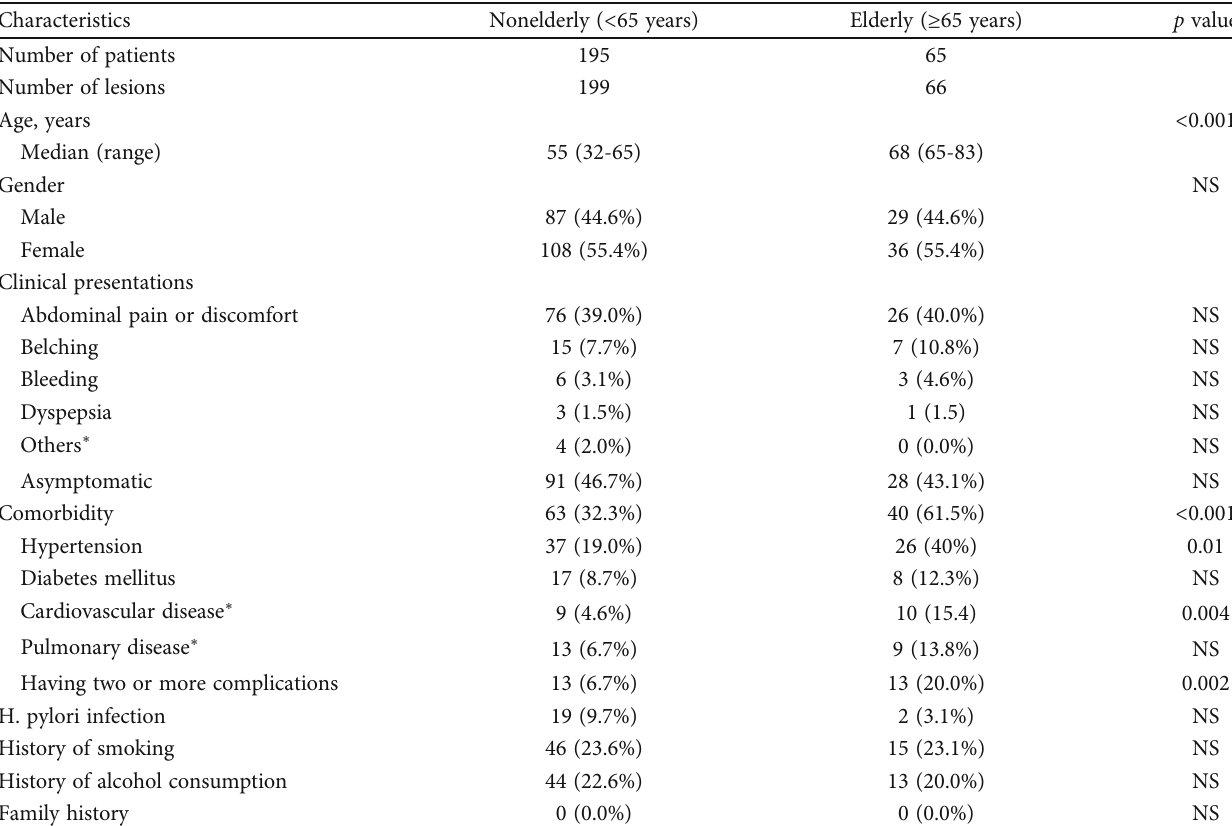
Figure 8: Recurrence-free survival according to age ( p = 0 : 395 ; not signi fi Table 1: Clinical characteristics of the patients.